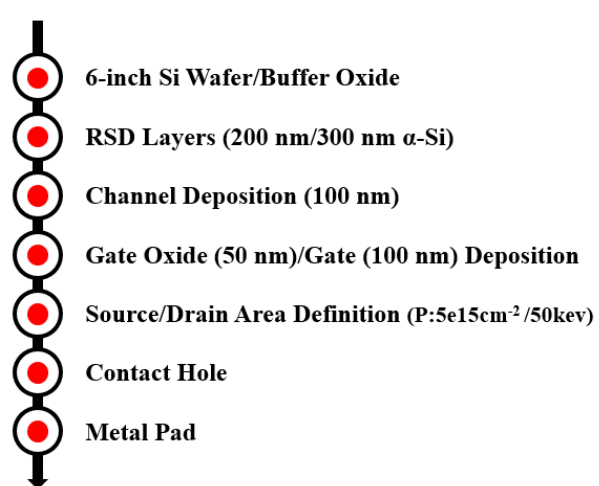
Figure 2. The simulation flow diagram for the ISE-TCAD device simulator.